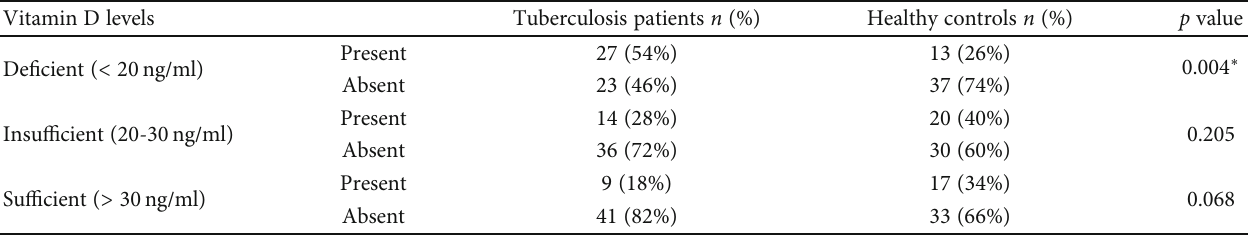
Table 2: Vitamin D levels among pulmonary tuberculosis patients ( N = 50 ) and controls ( N = 50 ).